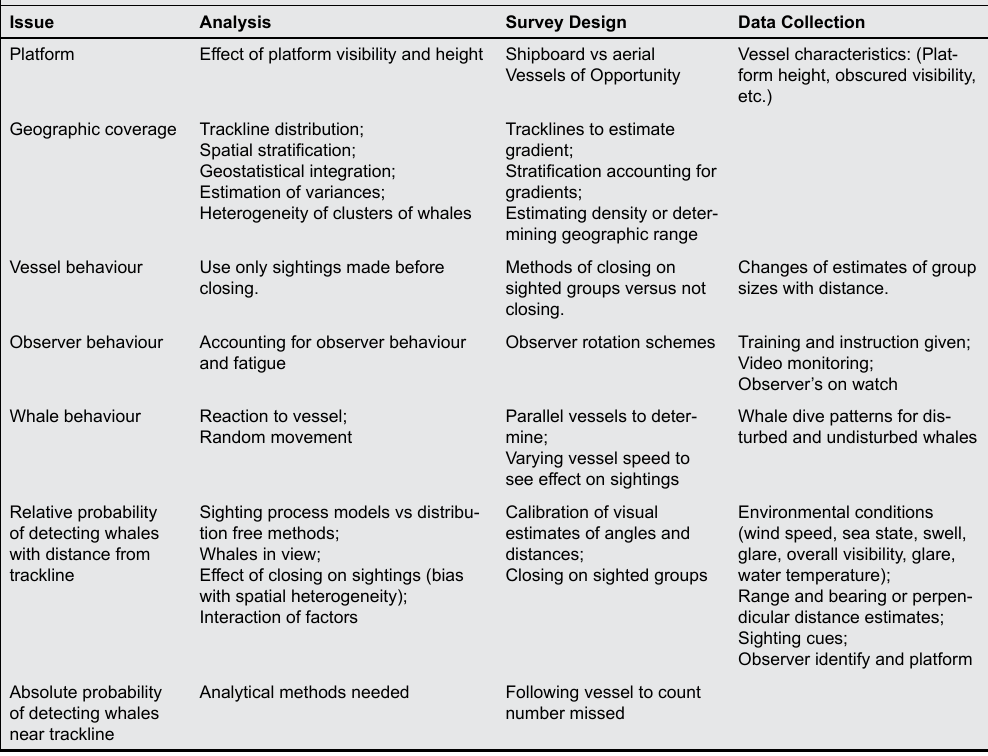
Table 2: Aspects of collection and analysis of cetacean sightings discussed during the 1980 “Workshop on the Design of Sightings Surveys”, identifying for each of seven issues the workshop’s analysis, survey design and data collection consid-